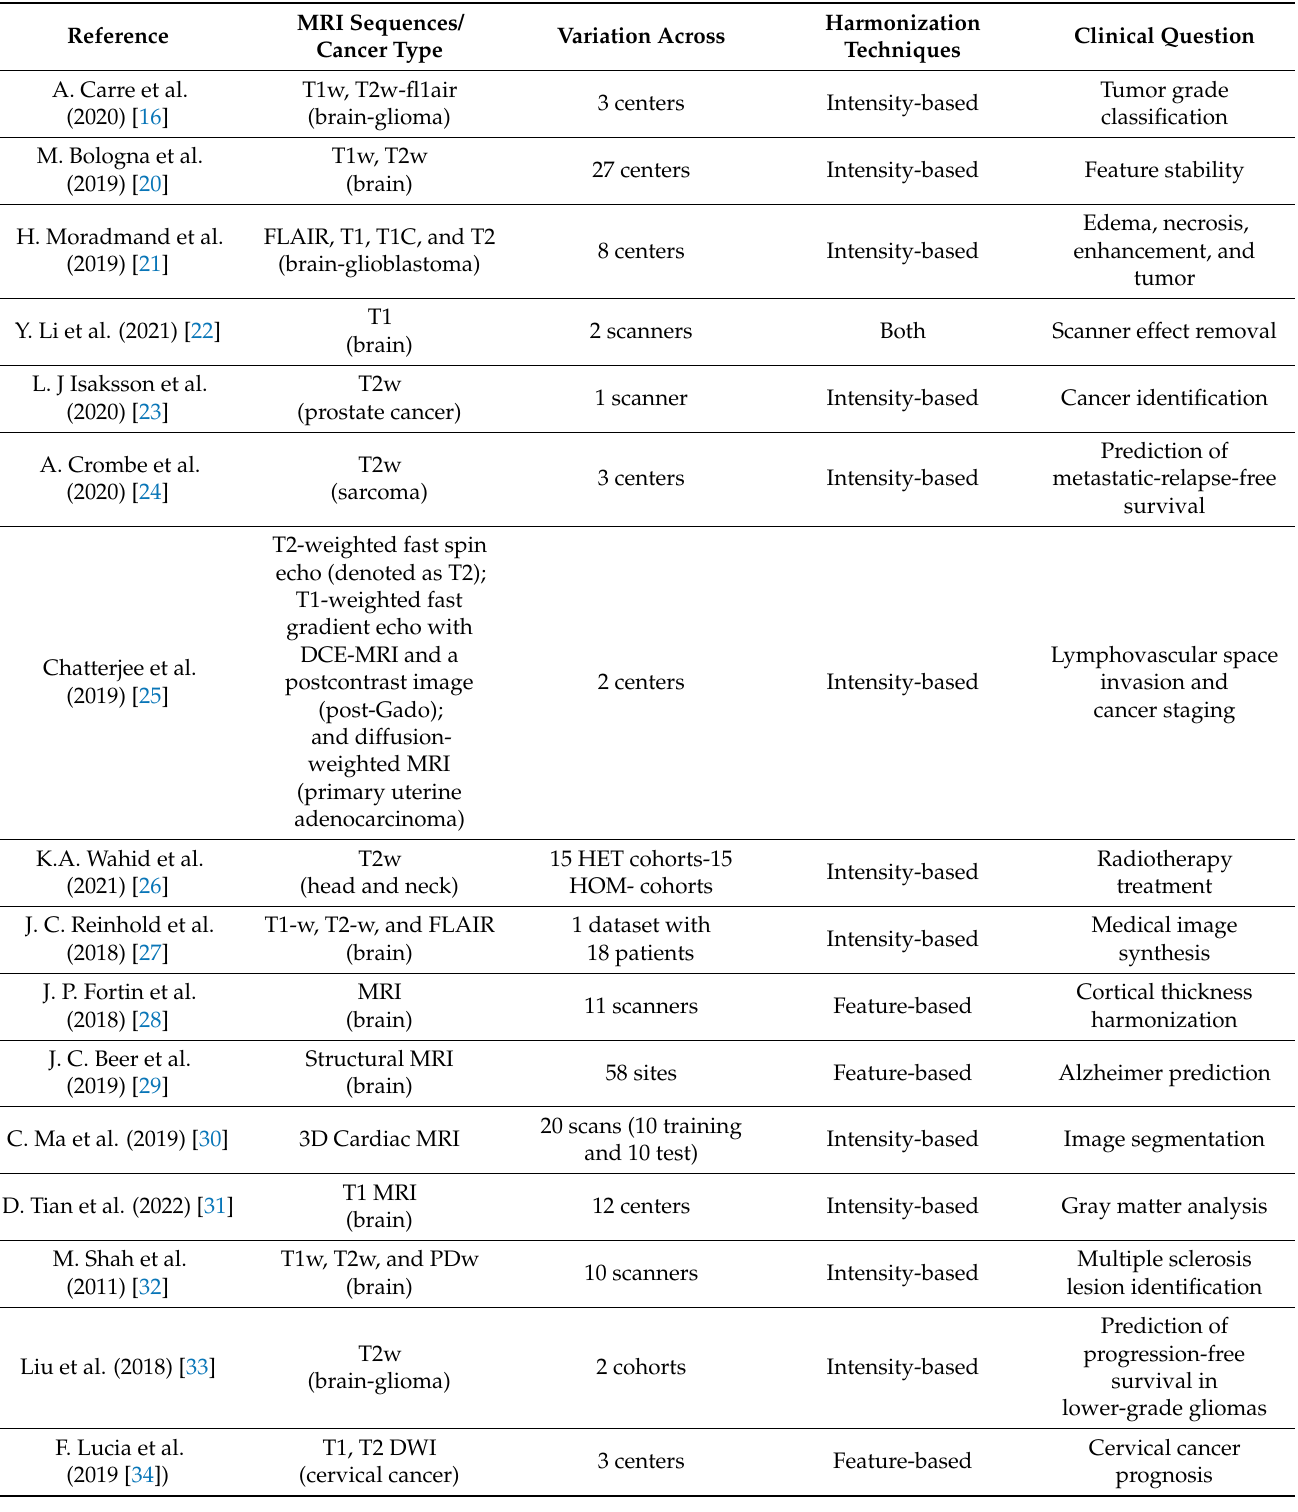
Table 1. Radiomics harmonization in recent multicenter MRI